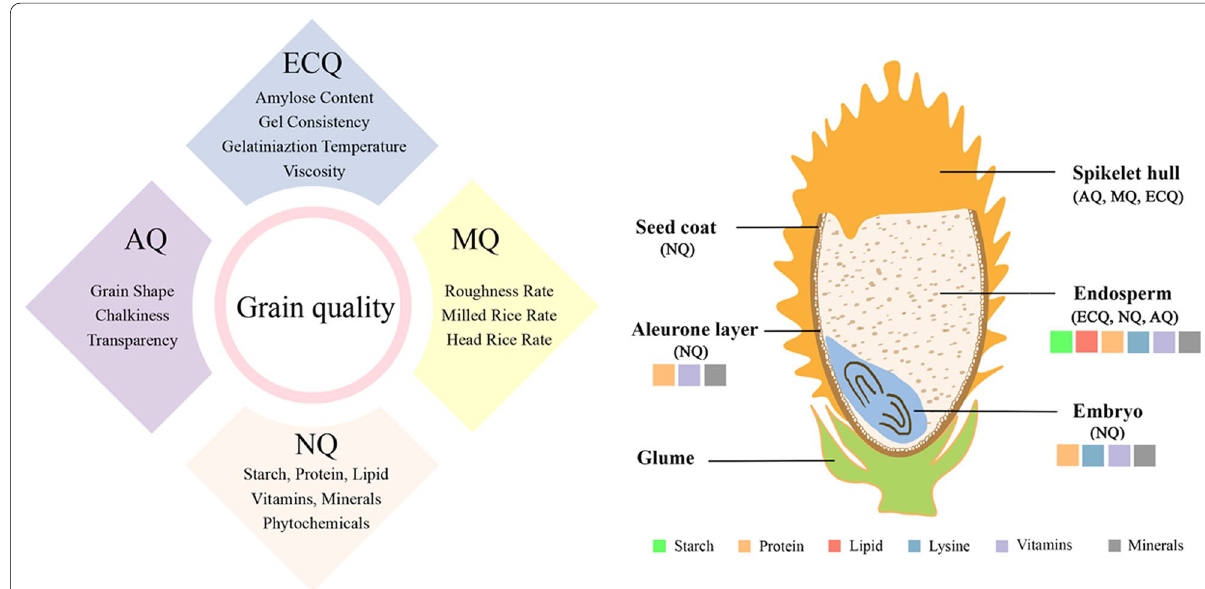
Fig. 1 This special issue covers the latest genetic and molecular insights on rice grain size and quality. The images are cited from Li et al. (2022a, Rice 15:18) showing the longitudinal section of a mature rice grain (right) and the four components that comprise the scope of rice quality